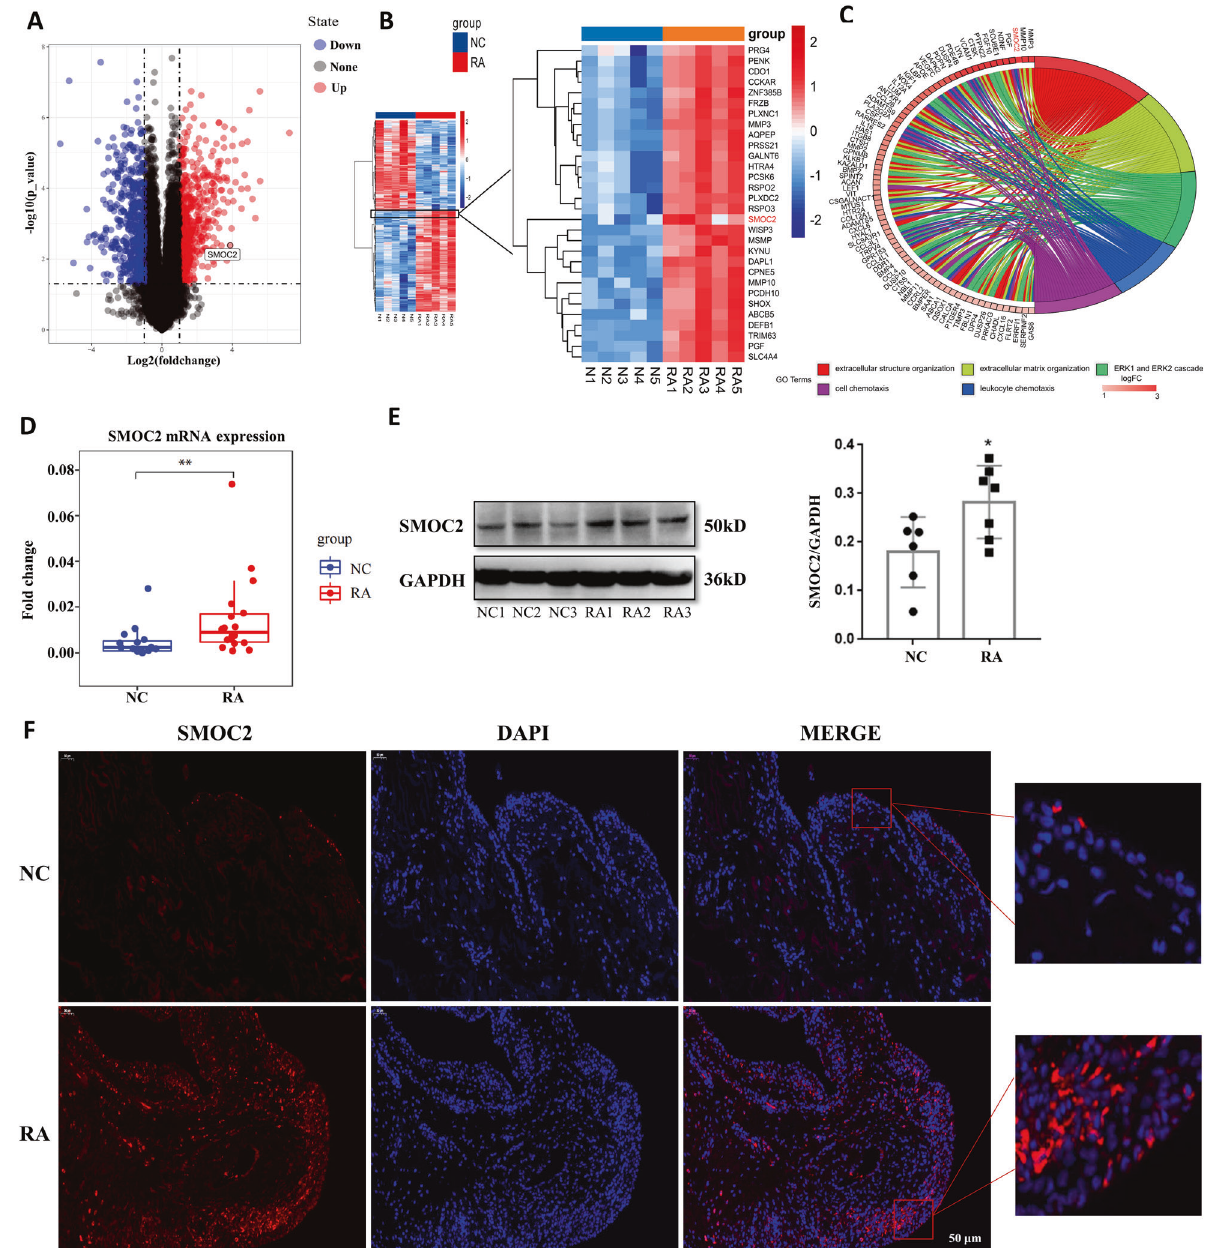
Fig. 1 Increased expression of SMOC2 in FLSs and STs from patients with RA. A Microarray analysis was performed in FLSs isolated from 5 RA patients and 5 NCs. Volcano plot revealed differentially expressed mRNAs in RA FLSs compared with NCs. B Heatmap of signi fi cantly altered genes in RA FLSs compared with NCs (fold change-absolute (FC-abs) > 2 and p < 0.05). SMOC2 was one of the most upregulated genes in RA FLSs. C GO-BP analysis of the upregulated genes between RA FLSs and NC FLSs. D , E The expression level of SMOC2 was con fi rmed by RT-qPCR ( D ) and western blot ( E ) in RA FLSs and NC FLSs. F Localization and expression of SMOC2 were assessed by immuno fl uorescence staining in STs from RA patients and NCs. Shown are representative images of SMOC2 (red) and nuclei (blue). Original magni fi cation, ×200. Data are presented as the mean ± SD; ** P < 0.01, * P <